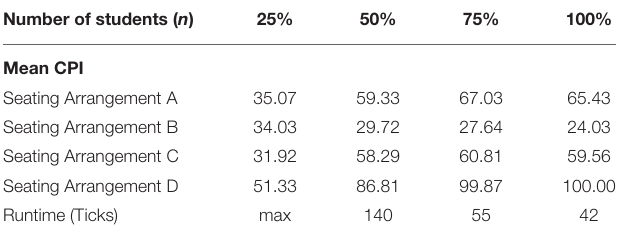
Number of students ( n